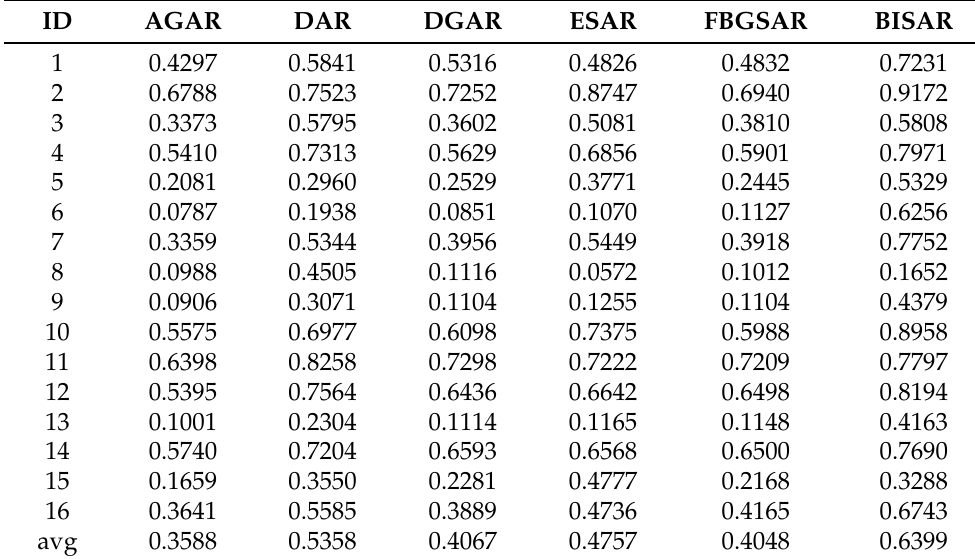
Table 4. The stabilities of reducts (feature